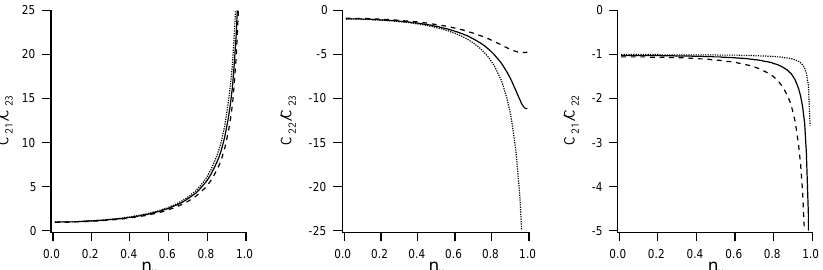
FIG. 2. The relative oscillation amplitude in quadrupole oscillation cases. Three different j have been considered, i.e., j (cid:1) 0.075 (dotted line), j (cid:1) 0.15 (solid line), and j (cid:1) 0.225 (broken line).